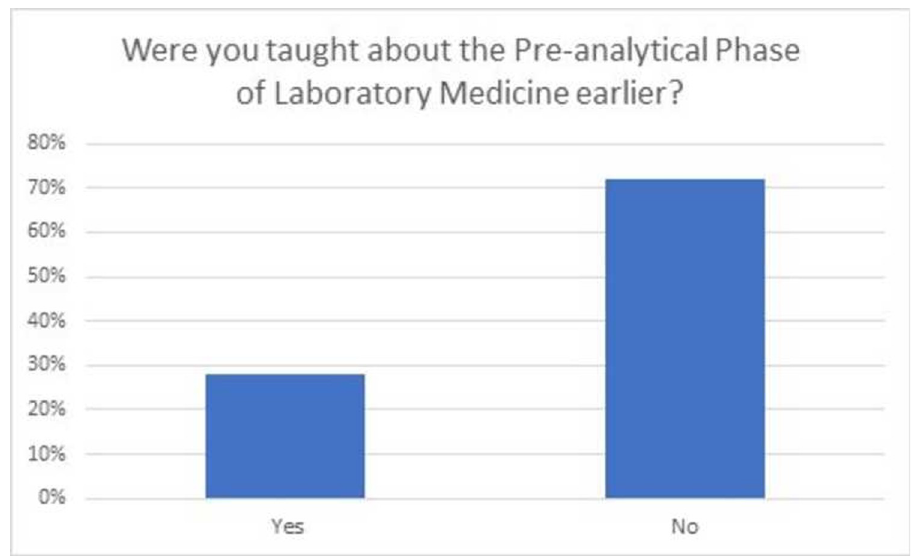
Fig 1. Students’ responses regarding prior knowledge related to the